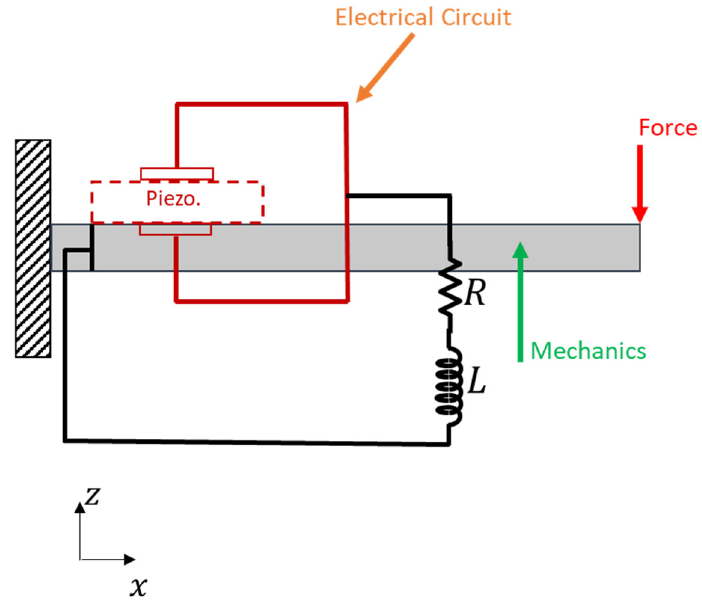
Figure 1. Mechanical model, interface to electrical circuit through a virtual PZT interface.